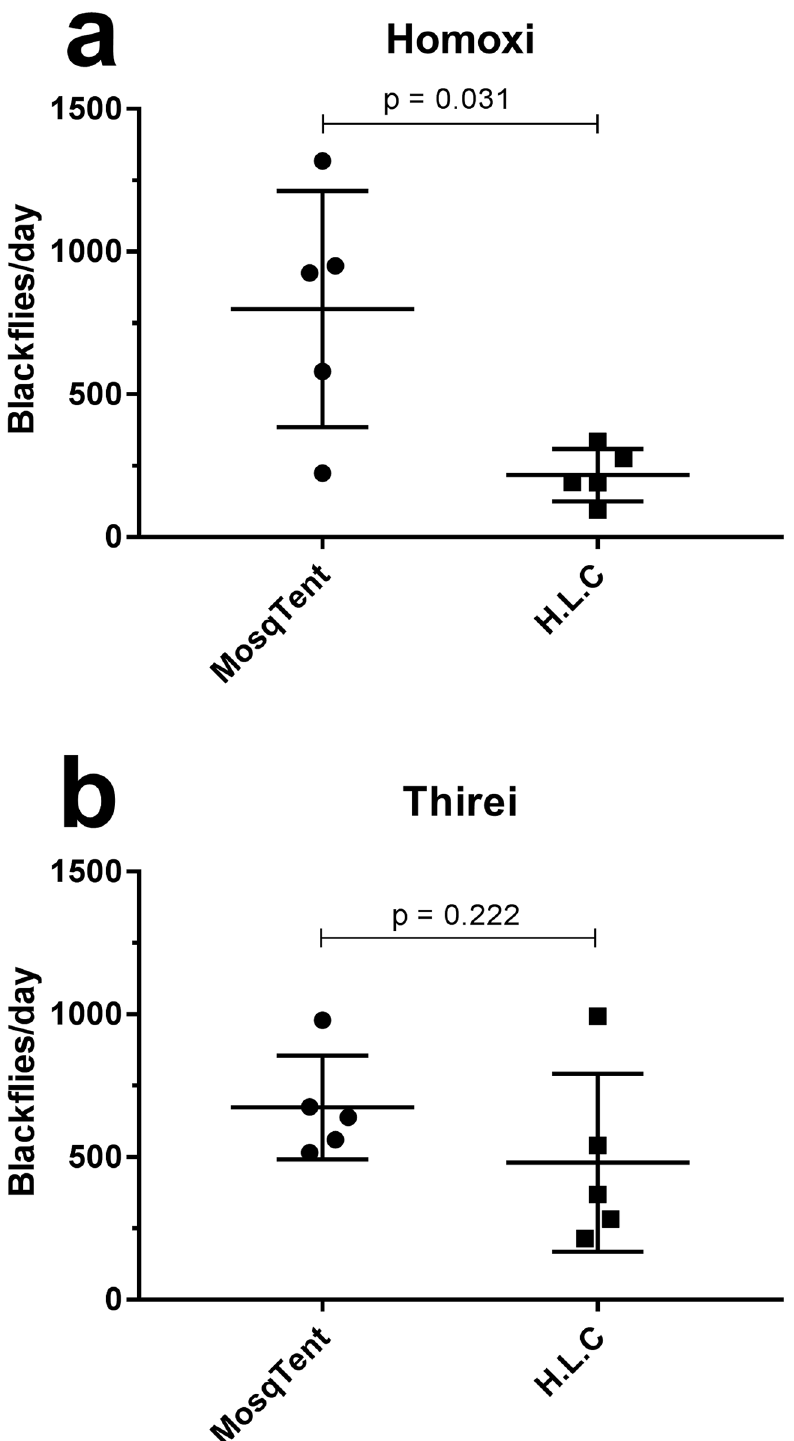
Fig 3. Simuliidae/day by the traditional HLC methodology at Homoxi (a) and Thirei (b).